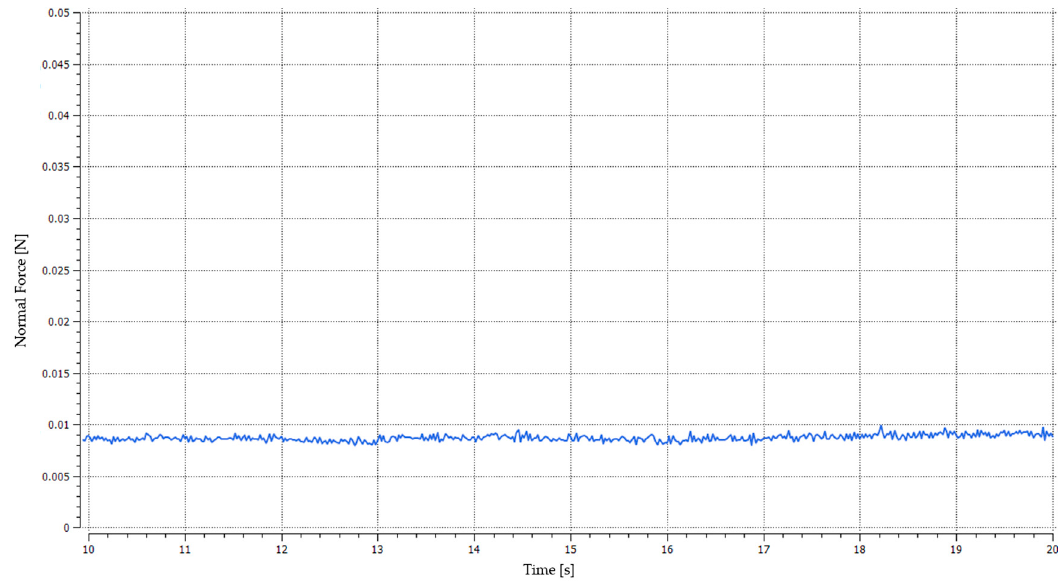
Figure 8. Standard deviation of the average force acting on the fruit in the normal direction reciprocating transport.